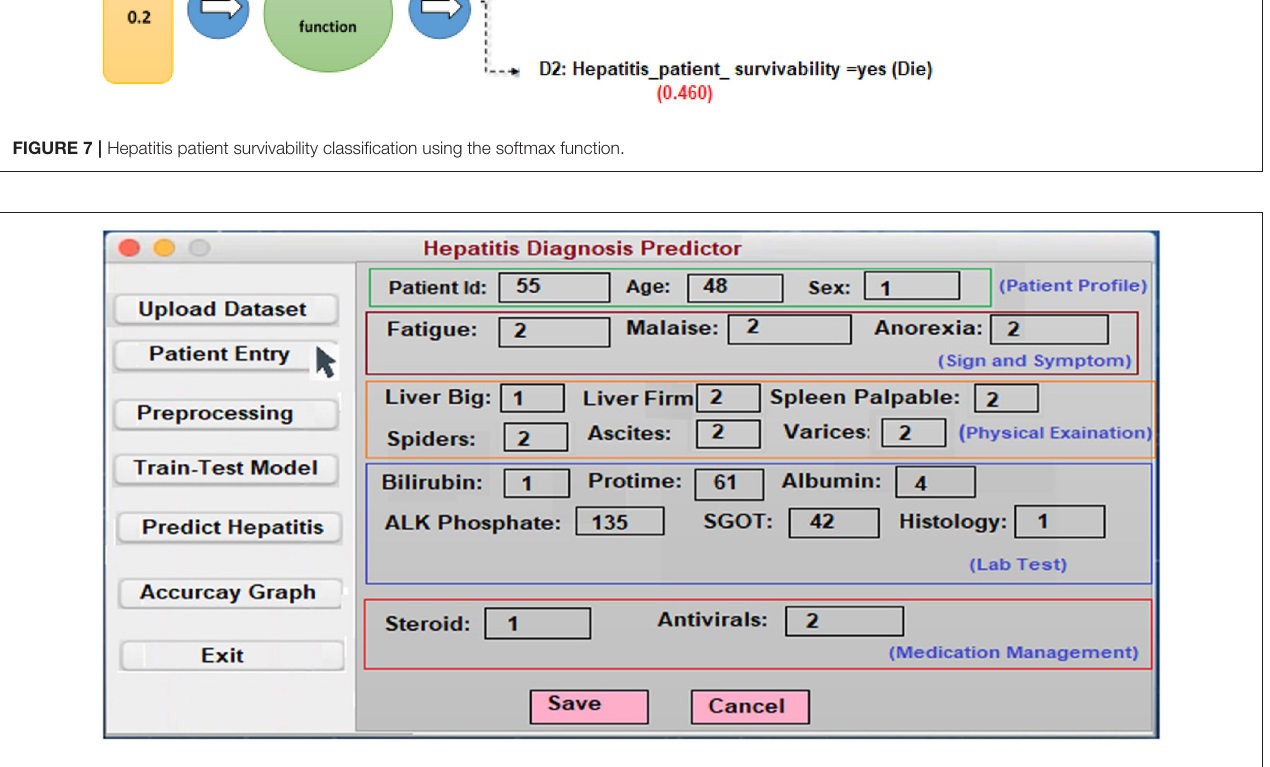
FIGURE 8 | Patient entry